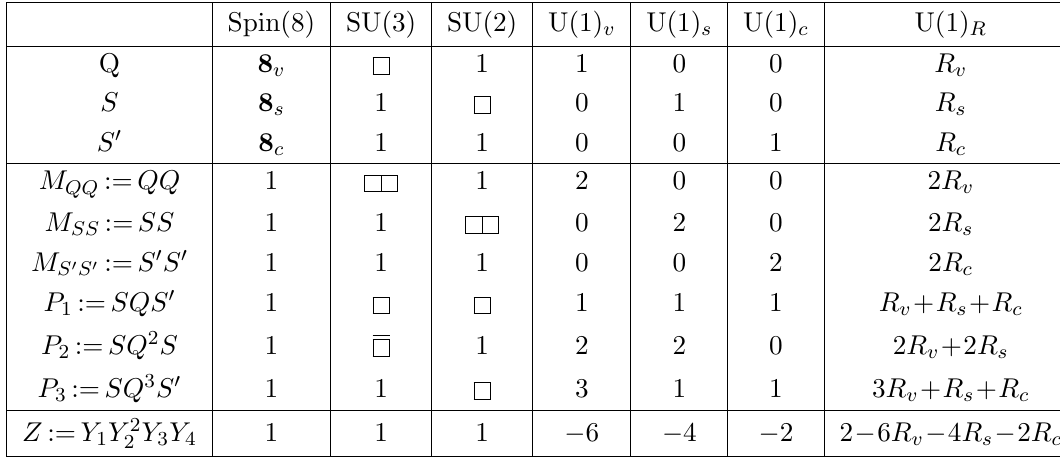
Table 5 . 3d N = 2 Spin(8) theory with ( N v ;N s ;N c ) = (3 ; 2 ; 1).